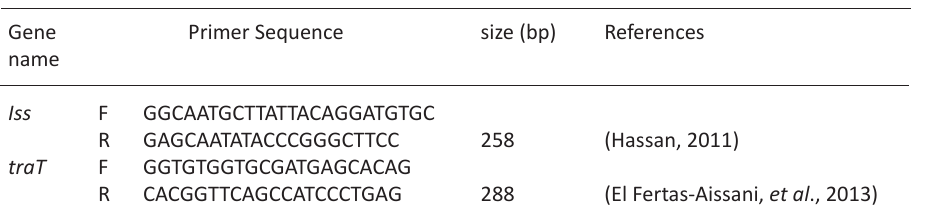
Table 1. The size and sequences of primers used in current study Gene Primer Sequence